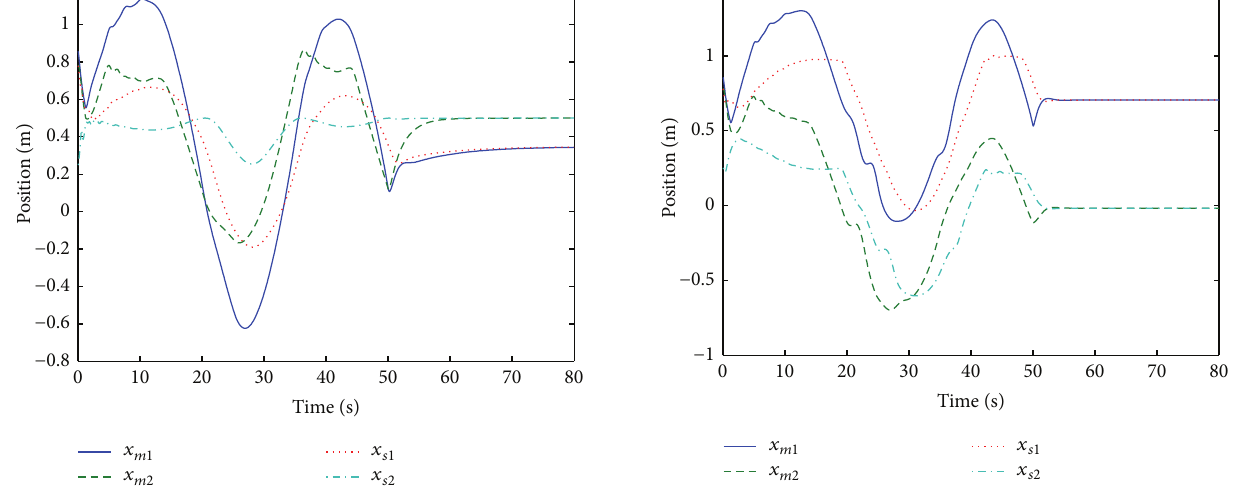
Figure 4: The positions of the master and the slave in task space without adaptive regulator.